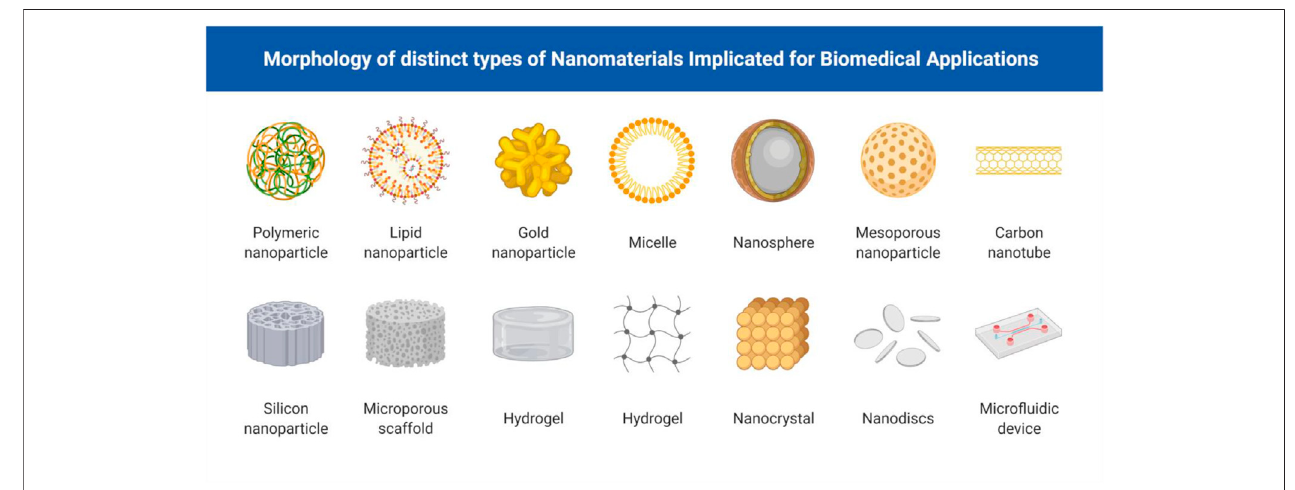
FIGURE 1 | Morphology of distinct types of nanomaterials implicated for biomedical applications including nanoparticles of size range between 1 and 100 nm, which includes hydrogels, Self – assembling peptides, Nano carriers, Liposomes, nanoparticles for therapy and diagnosis of AD.